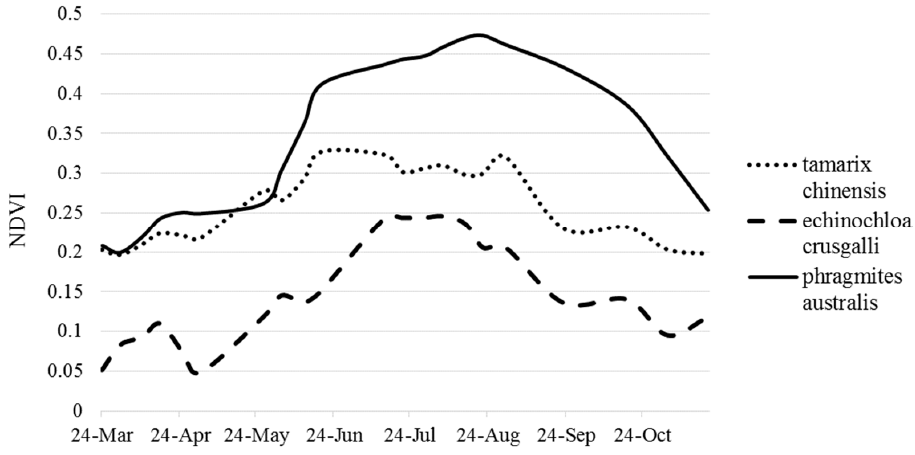
Figure 2. The normalized difference vegetation index (NDVI) time series curves of three wetland vegetation after harmonic analysis.